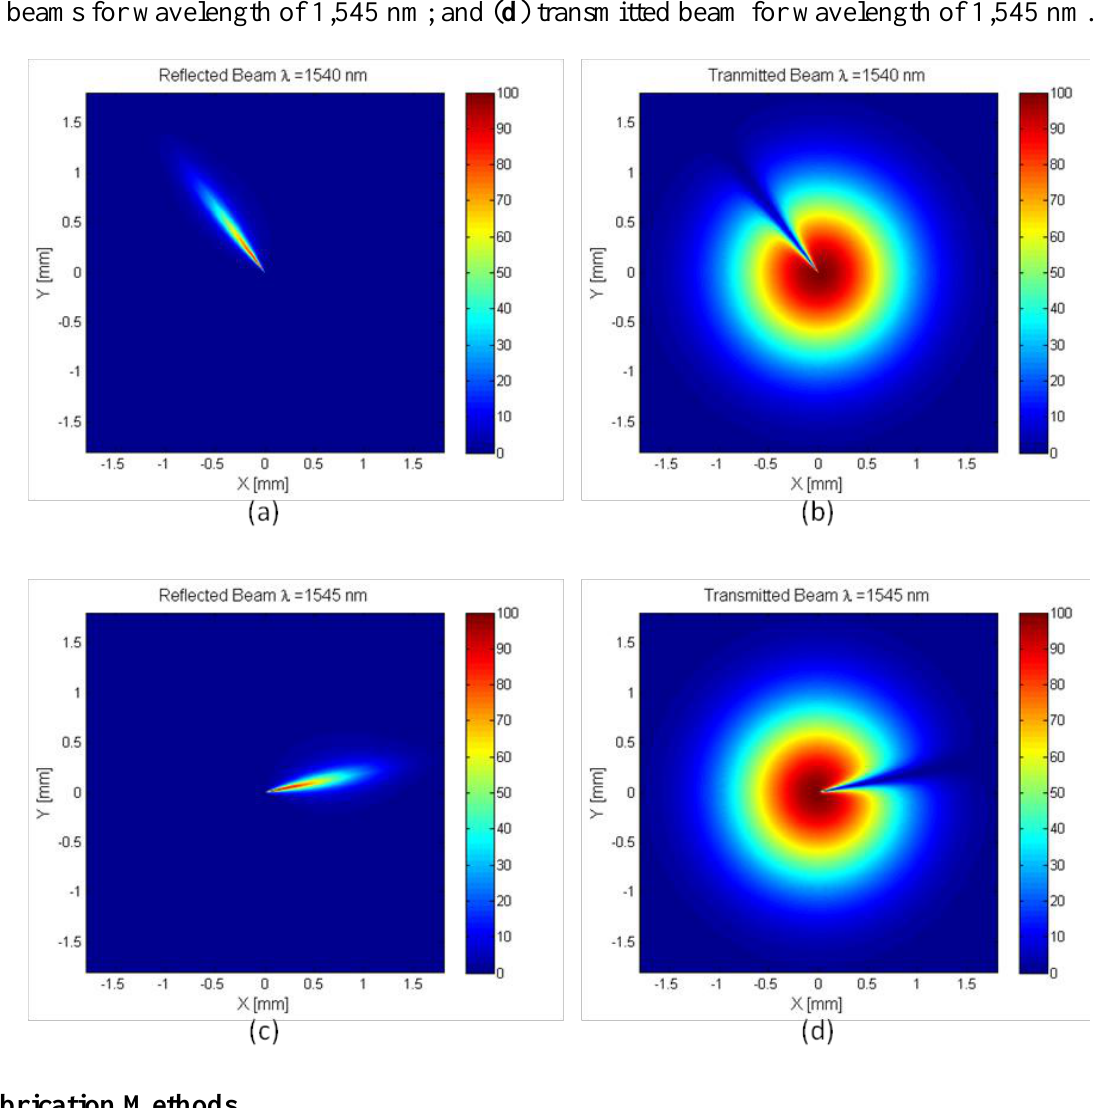
Figure 7. Simulated Transmission and Reflection Beam profiles. ( a ) reflected beam for wavelength of 1,540 nm; ( b ) transmitted beam for wavelength of 1,540 nm; ( c ) reflected beams for wavelength of 1,545 nm; and ( d ) transmitted beam for wavelength of 1,545